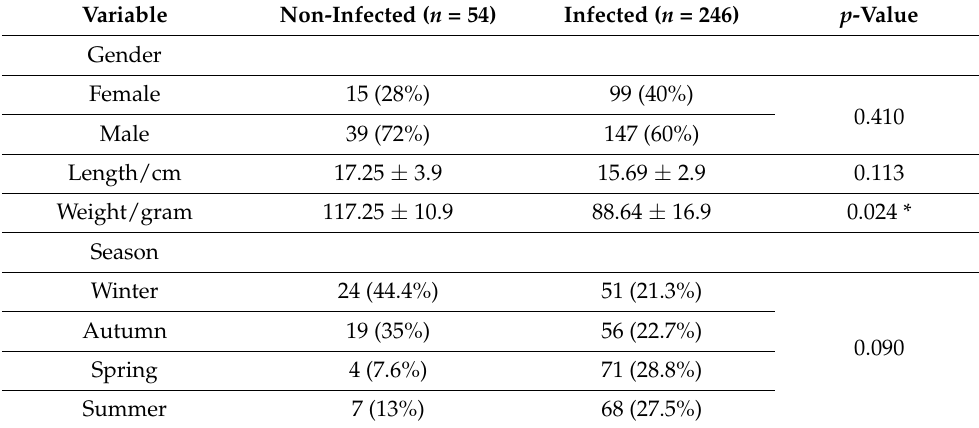
Table 1. Infection rate in relation to sex, size, weight and seasonal variation in Nile tilapia ( Oreochromis niloticus ).